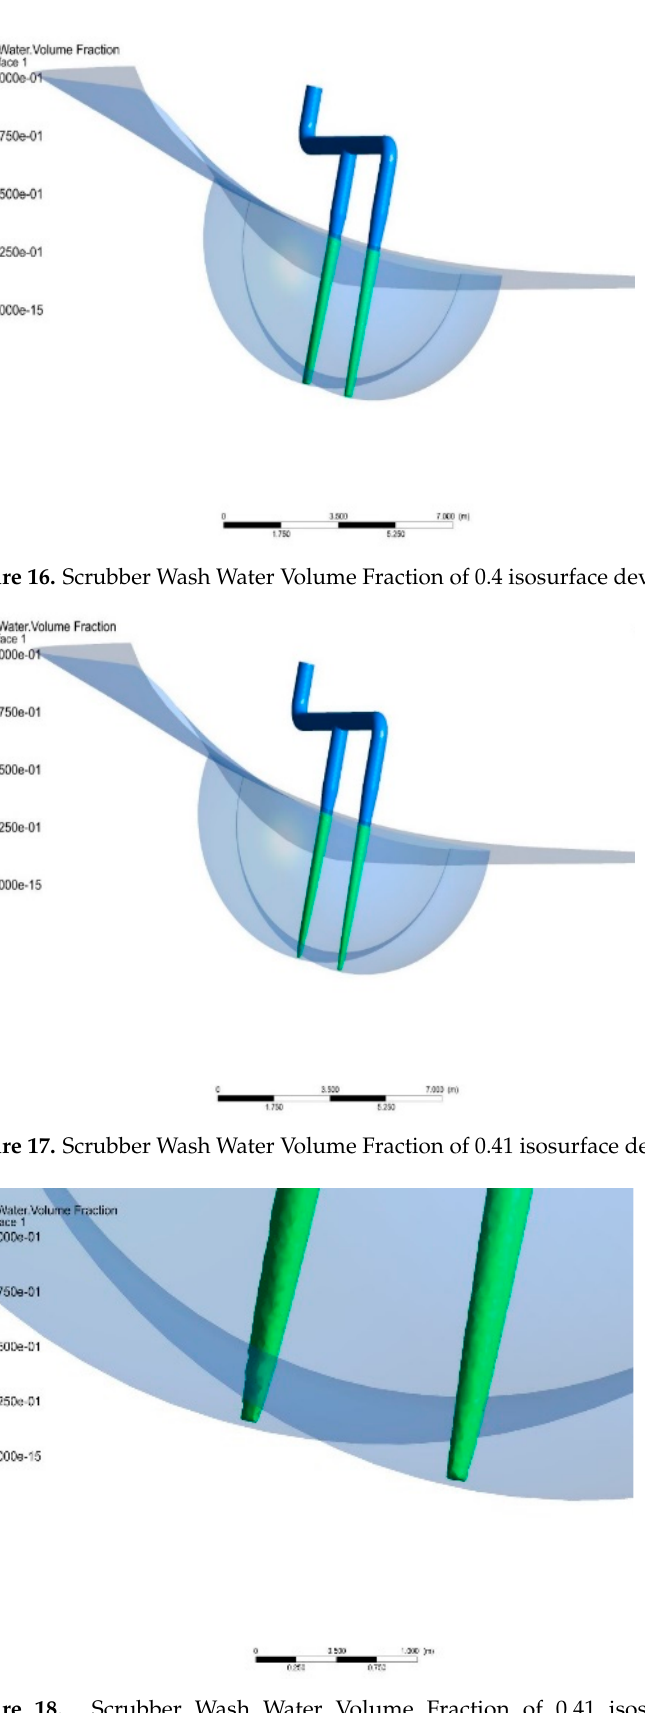
Figure 15. Scrubber Wash Water Volume Fraction of 0.3 isosurface development.